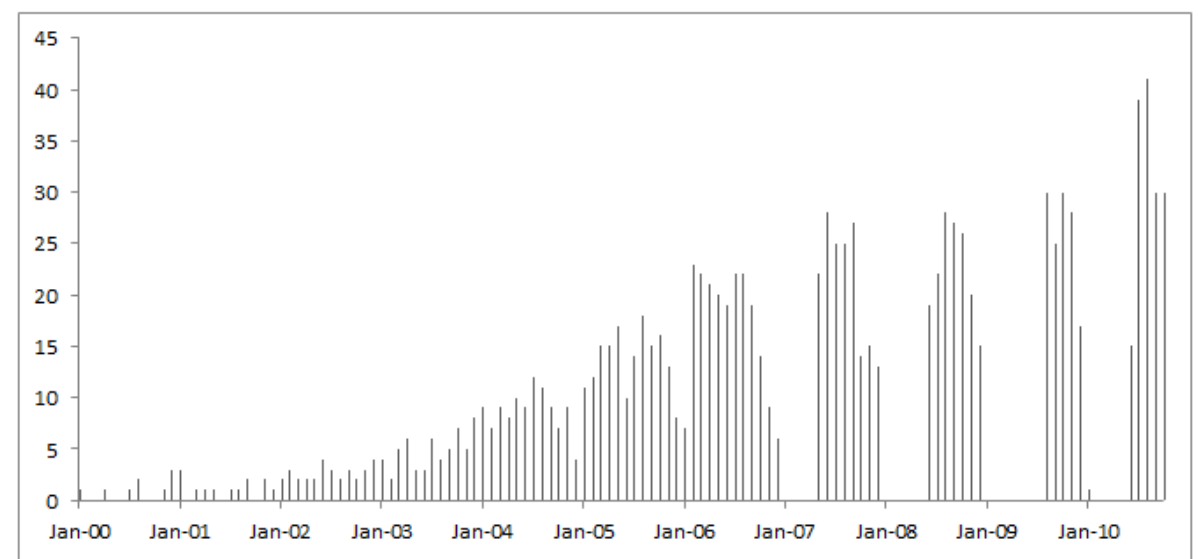
Figure 1. Data contribution rates over the past decade by U.S.